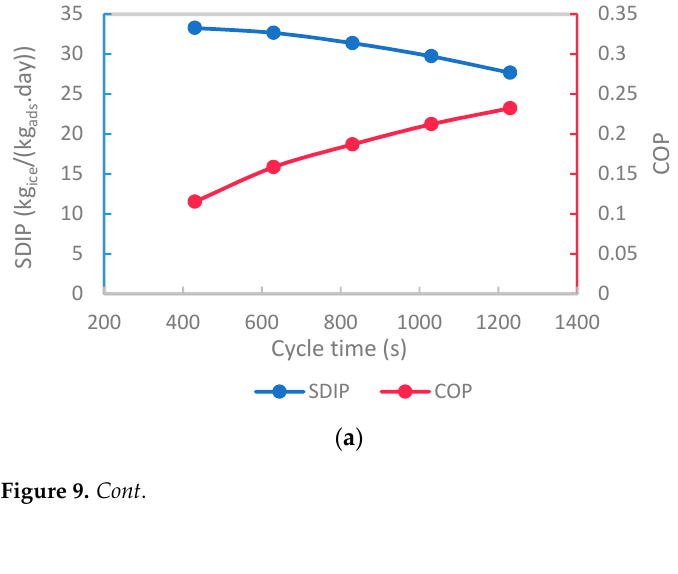
tem has increased by increasing the cycle time regardless of the composite thickness. A maximum SDIP of 33.27 kg ice ·kg ads − 1 ·day − 1 was attained at the shortest cycle time of 430 s and the smallest composite thickness of 2 mm. Nevertheless, the system COP reached its maximum value of 0.3046 at the longer cycle time of 1230 with 5 mm composite thickness, and the SDIP associated with this case was 23.27 kg ice ·kg ads − 1 ·day − 1 . The changing range of the SDIP over different cycle times was considerably reduced by increasing the composite thickness as it can be seen by comparing the range of the SDIP given in Figure 9a–c. This was attributed to the reduction in the effective uptake with thicker composite thickness.